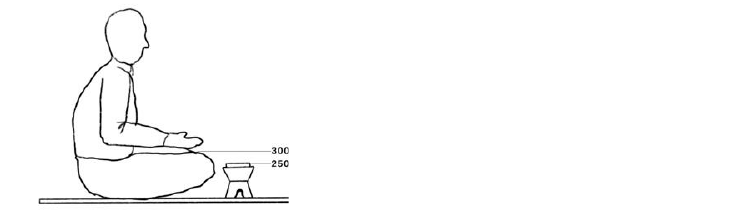
Figure 3. The difference between the height of a standard rehal and the height where the hands of an average adult male would rest.